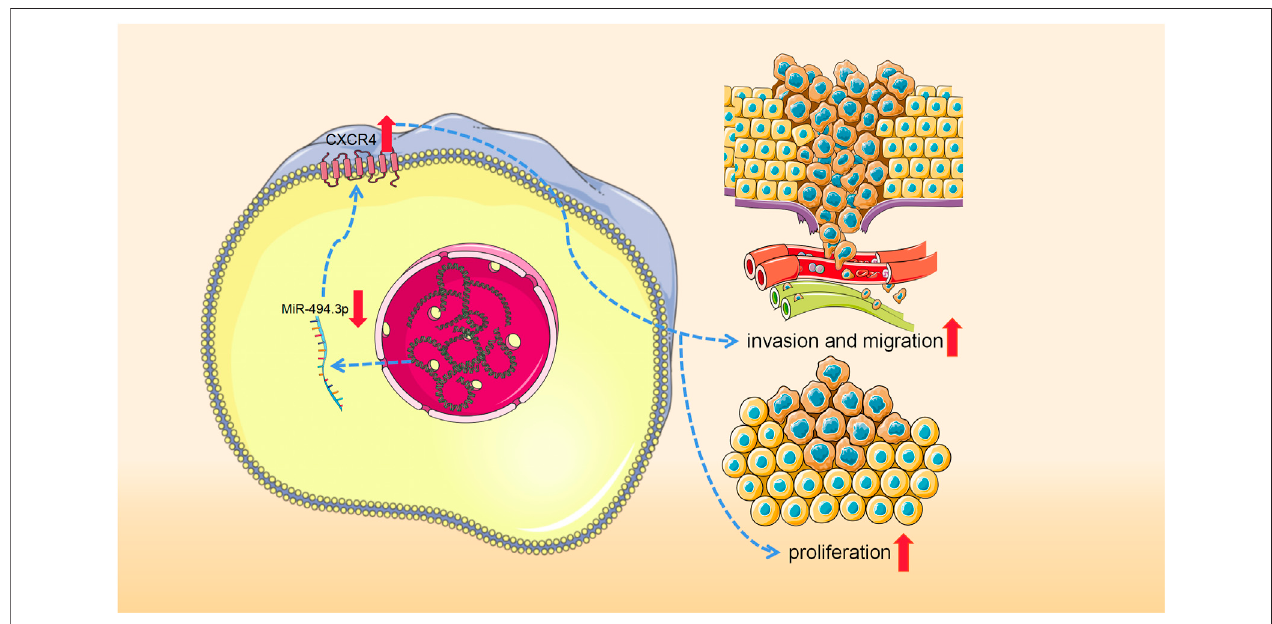
FIGURE 1 | Low expression of miRNA-494-3p results in the increased expression of CXCR4, thus promoting the development of synovial